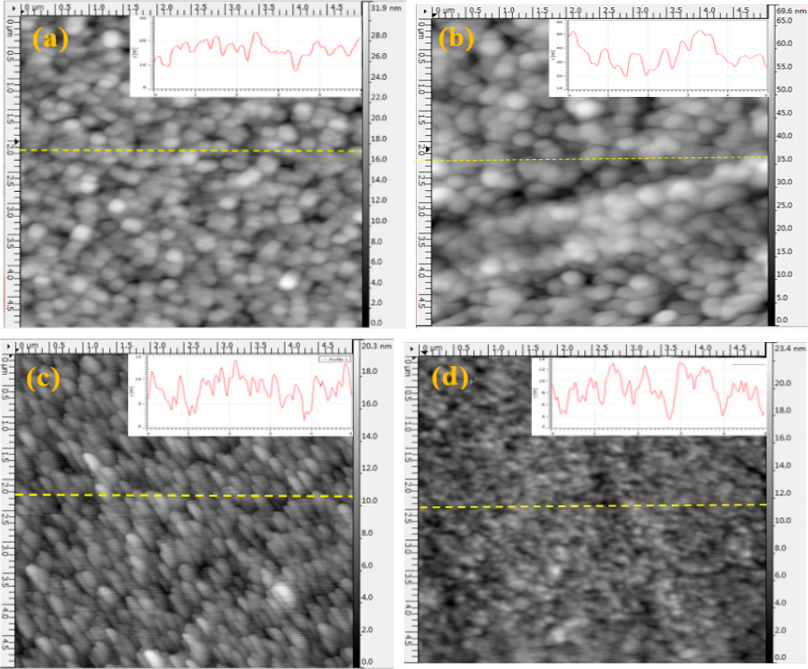
Figure 5. Two-dimensional surface morphologies of CdTe films prepared at different substrate-target distances, D ts . ( a ) 3.5 cm; ( b ) 4 cm; ( c ) 4.5 cm; and ( d ) 5 cm.